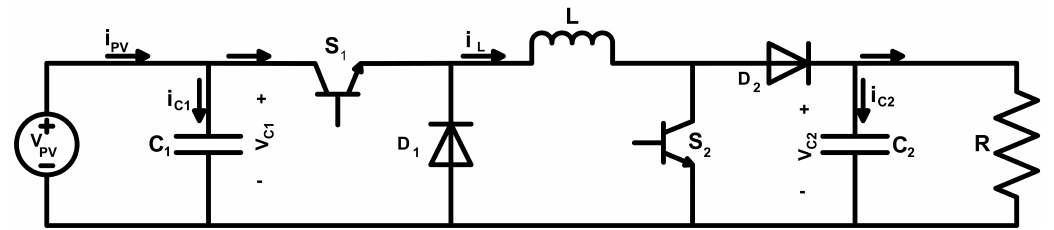
Figure 13. Noninverting Buck-Boost